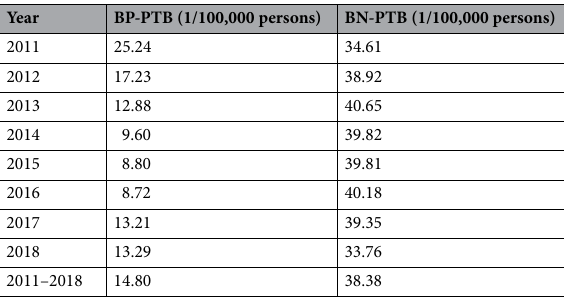
Table 1. The notified incidence rate of BP-PTB and BN-PTB in Shaanxi (2011–2018).